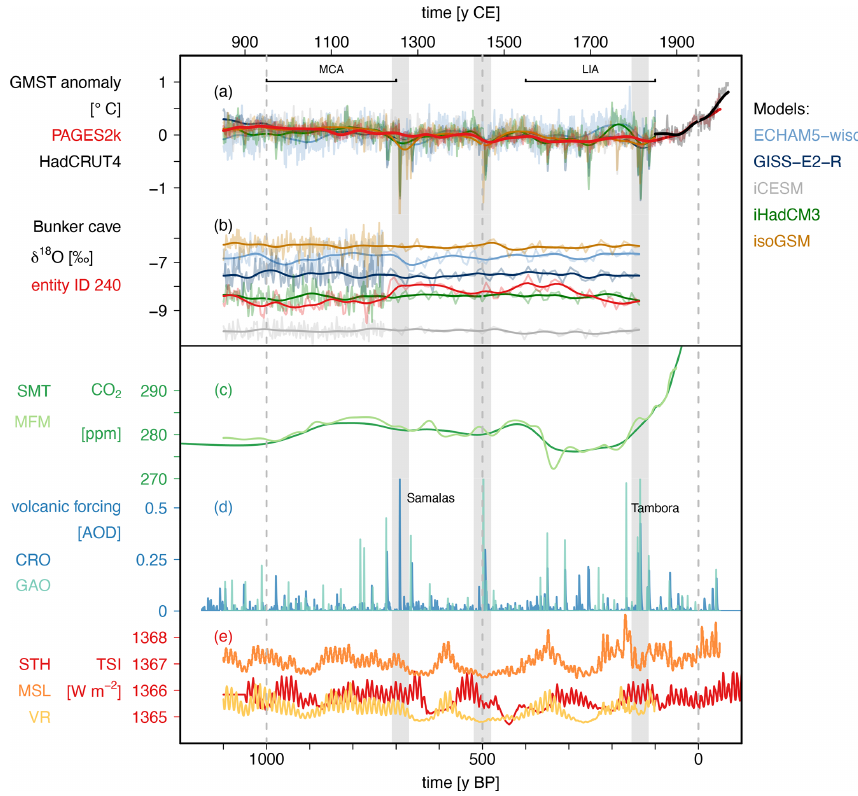
Figure 1. Climate as represented by the different models (ECHAM5-wiso: light blue; GISS-E2-R: dark blue; iCESM: grey; iHadCM3: green; and isoGSM: orange) and external forcings over the last millennium. (a) Global mean surface temperature anomaly as represented by the models (in model colors) relative to the period of the last millennium (850–1850CE), the reconstructed temperature anomaly (PAGES2k, red, PAGES2k-Consortium, 2019), and observed temperatures (HadCRUT4, black, Morice et al., 2012). (b) Isotopic composition of precipitation in the different models (in model colors) at the cave site location of Bunker cave (Germany), including the δ 18 O speleo of entity ID 240 (red), all at the temporal resolution of entity ID 240 (Comas-Bru et al., 2020b; Fohlmeister et al., 2012). For both temperature and δ 18 O, we show the annual and downsampled values in lighter colors in the background. Bold colors show the values with a 100-year Gaussian kernel bandpass (Rehfeld and Kurths, 2014). (c) Atmospheric CO 2 concentration (SMT: Schmidt et al., 2012; MFM: MacFarling Meure et al., 2006). (d) Volcanic forcing in units of aerosol optical depth (AOD) (CRO: Crowley et al., 2008; Crowley and Unterman, 2013; GAO: Gao et al., 2008), where the AOD for the Gao et al. (2008) reconstruction was estimated by dividing the sulfate loading by 150Tg (following Atwood et al., 2016). (e) Total solar irradiance (TSI) (STH: Steinhilber et al., 2009, MSL: Muscheler et al., 2016, VR: Vieira et al., 2011). The grey bars mark particular periods of high volcanic